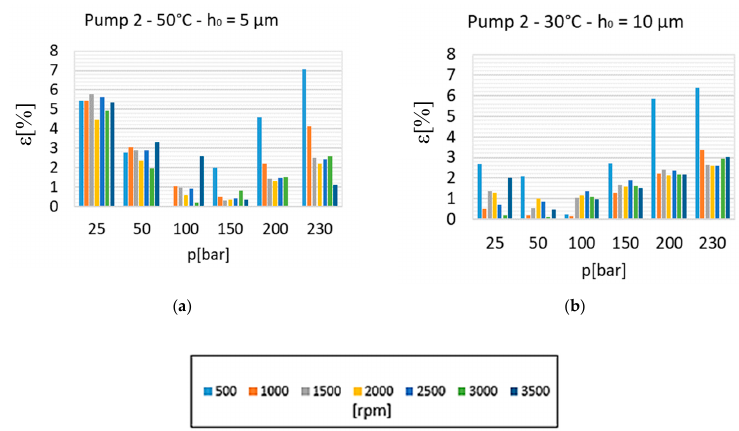
Figure 8. Relative errors on the calculation of the mechanical efficiency of pump 1 for different operating conditions and fluid temperature: (a) 30°C and h 0 =5 μ m ; (b) 30°C and h 0 =10 μ m; (c) 50°C and h 0 =5 μ m; (d) 50°C and h 0 =10 μ m